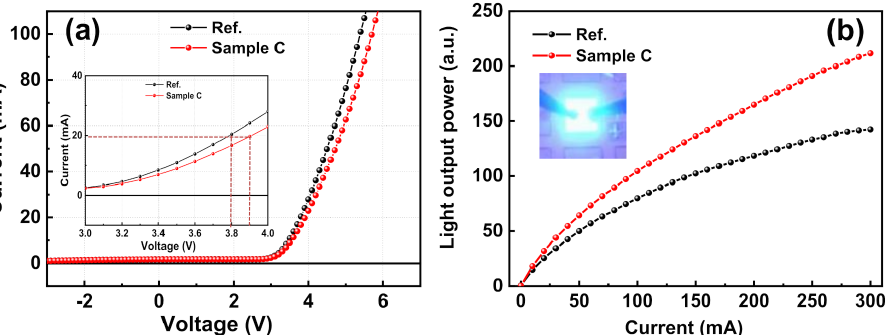
Figure 5. ( a ) Current-voltage (I-V) characteristics and ( b ) optical output power of the reference sample and a sample